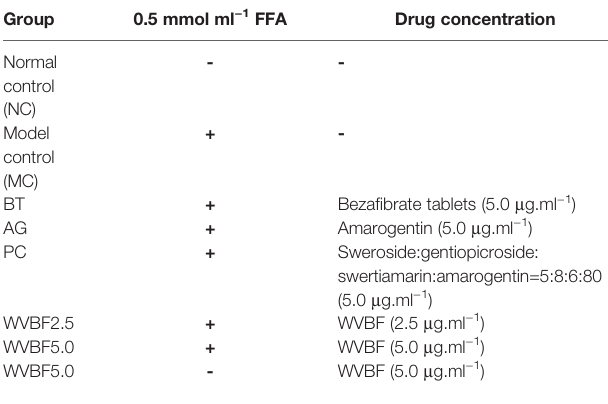
TABLE 1 | Experimental protocol and